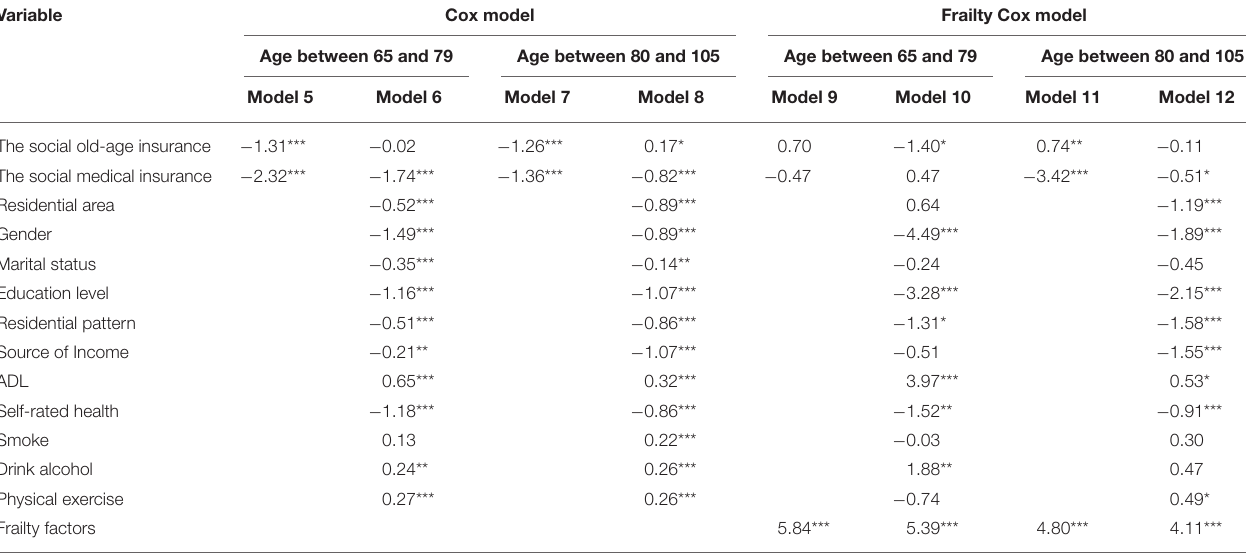
TABLE 3 | The regression results of the Cox model and the frailty Cox model under the samples of different age structures. Variable